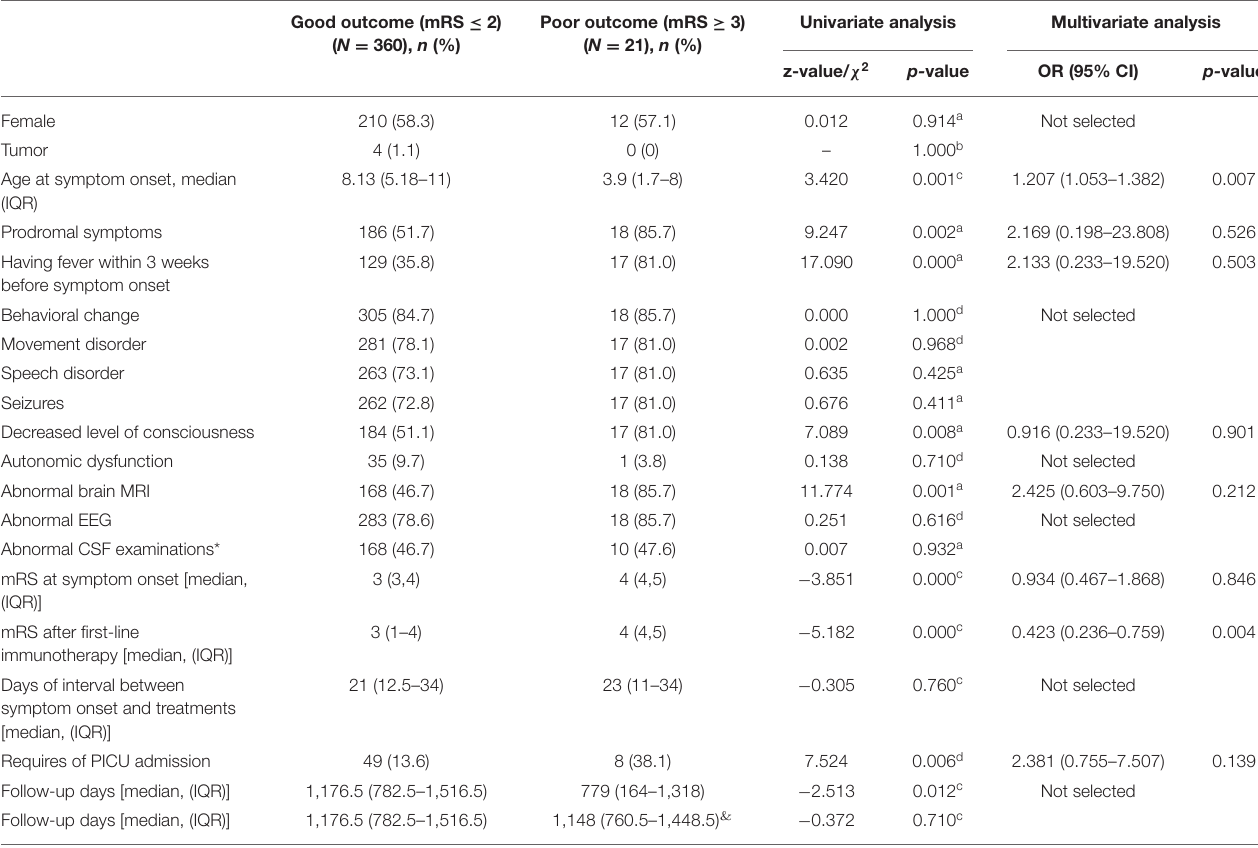
TABLE 2 | Comparison of clinical characteristics of patients with good and poor